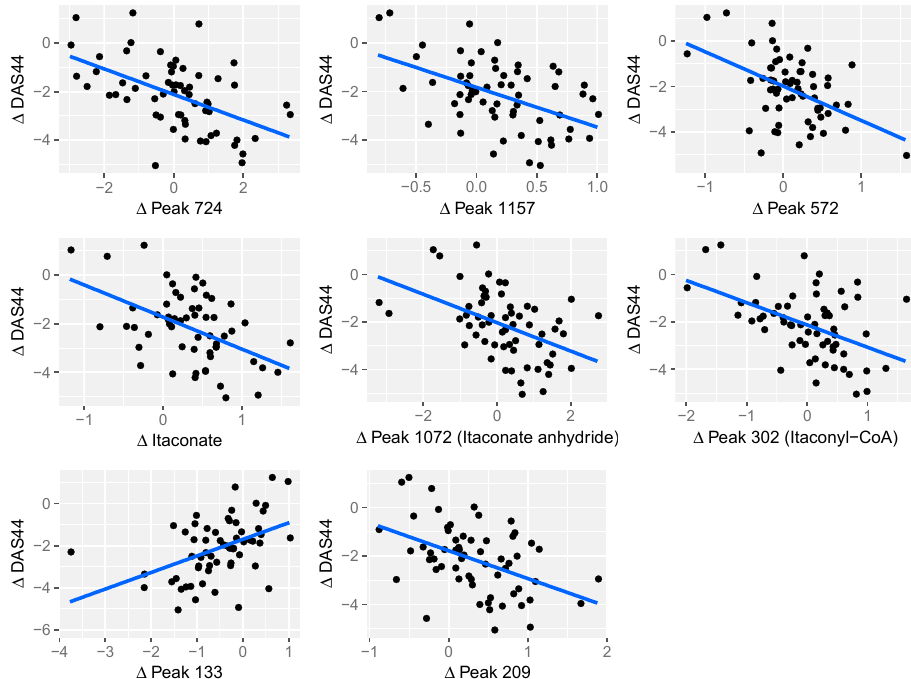
Figure 1. Volcano plot between baseline and three months. Blue points are significant peaks; orange points are not significant peaks.